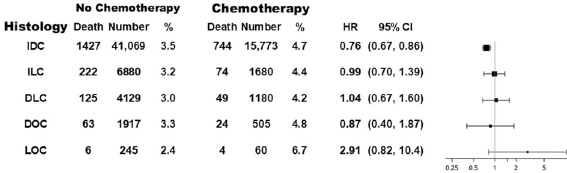
Fig. 5 Chemotherapy bene fi t in different histological subtypes. Evaluation of overall survival bene fi t from adjuvant chemotherapy in different tumor histologic subtypes (adjusted for age, race, ethnicity, rurality, median income and educational level of area of residence, RS, tumor size, grade, node involvement, and Charlson-Deyo comorbidity